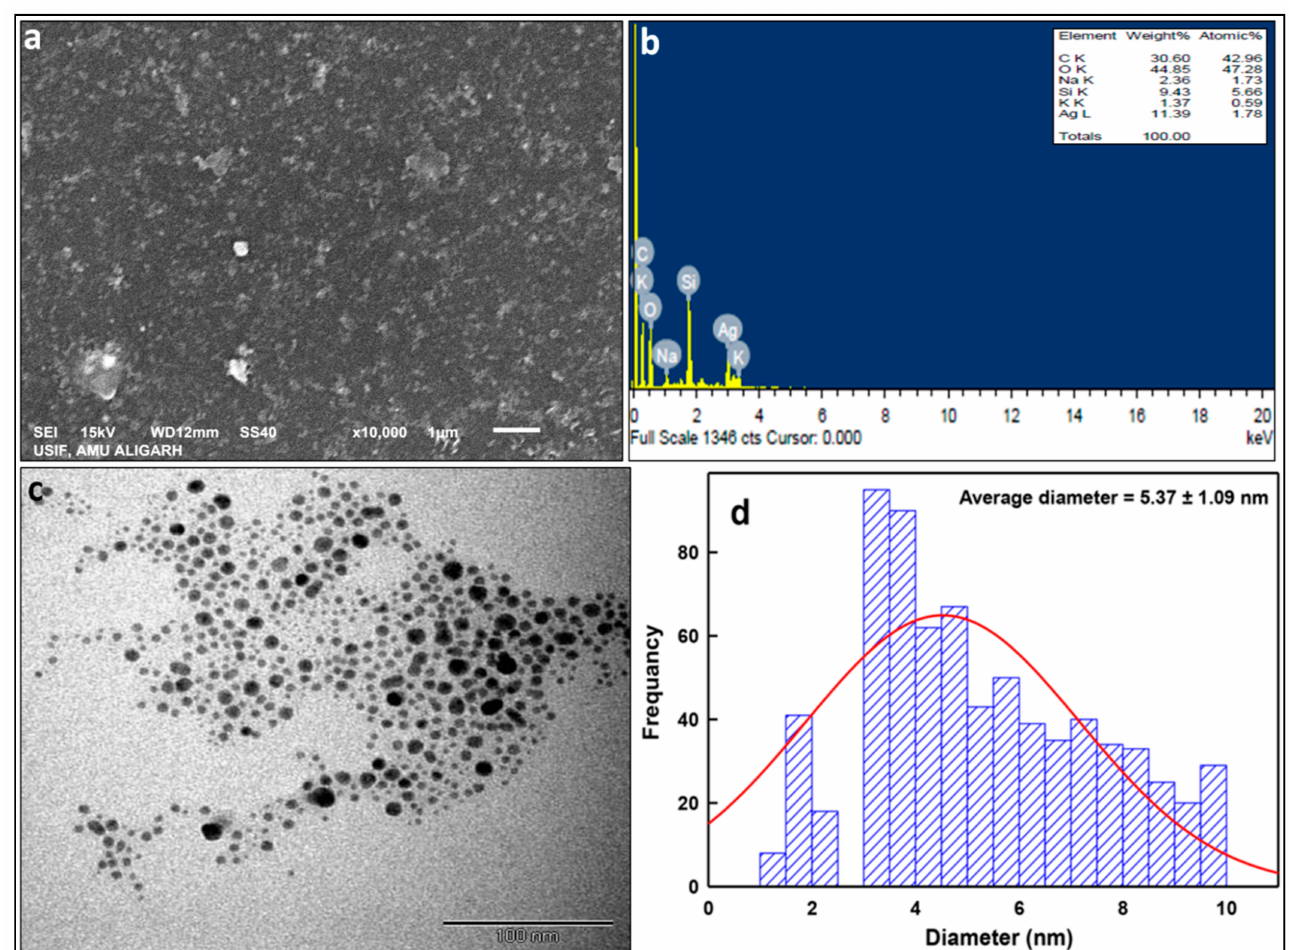
Figure 5. Electron microscopic analyses. Panel ( a ) shows SEM micrographs of LIV-AgNPs. Whereas, energy dispersive X-ray spectrum in panel ( b ) represents the percentage of Ag, C, O, NA, K and Si elements present in LIV-AgNPs. Panel ( c ) demonstrates TEM image of LIV-AgNPs whereas, panel ( d ) depicts the particle size distribution in TEM images,